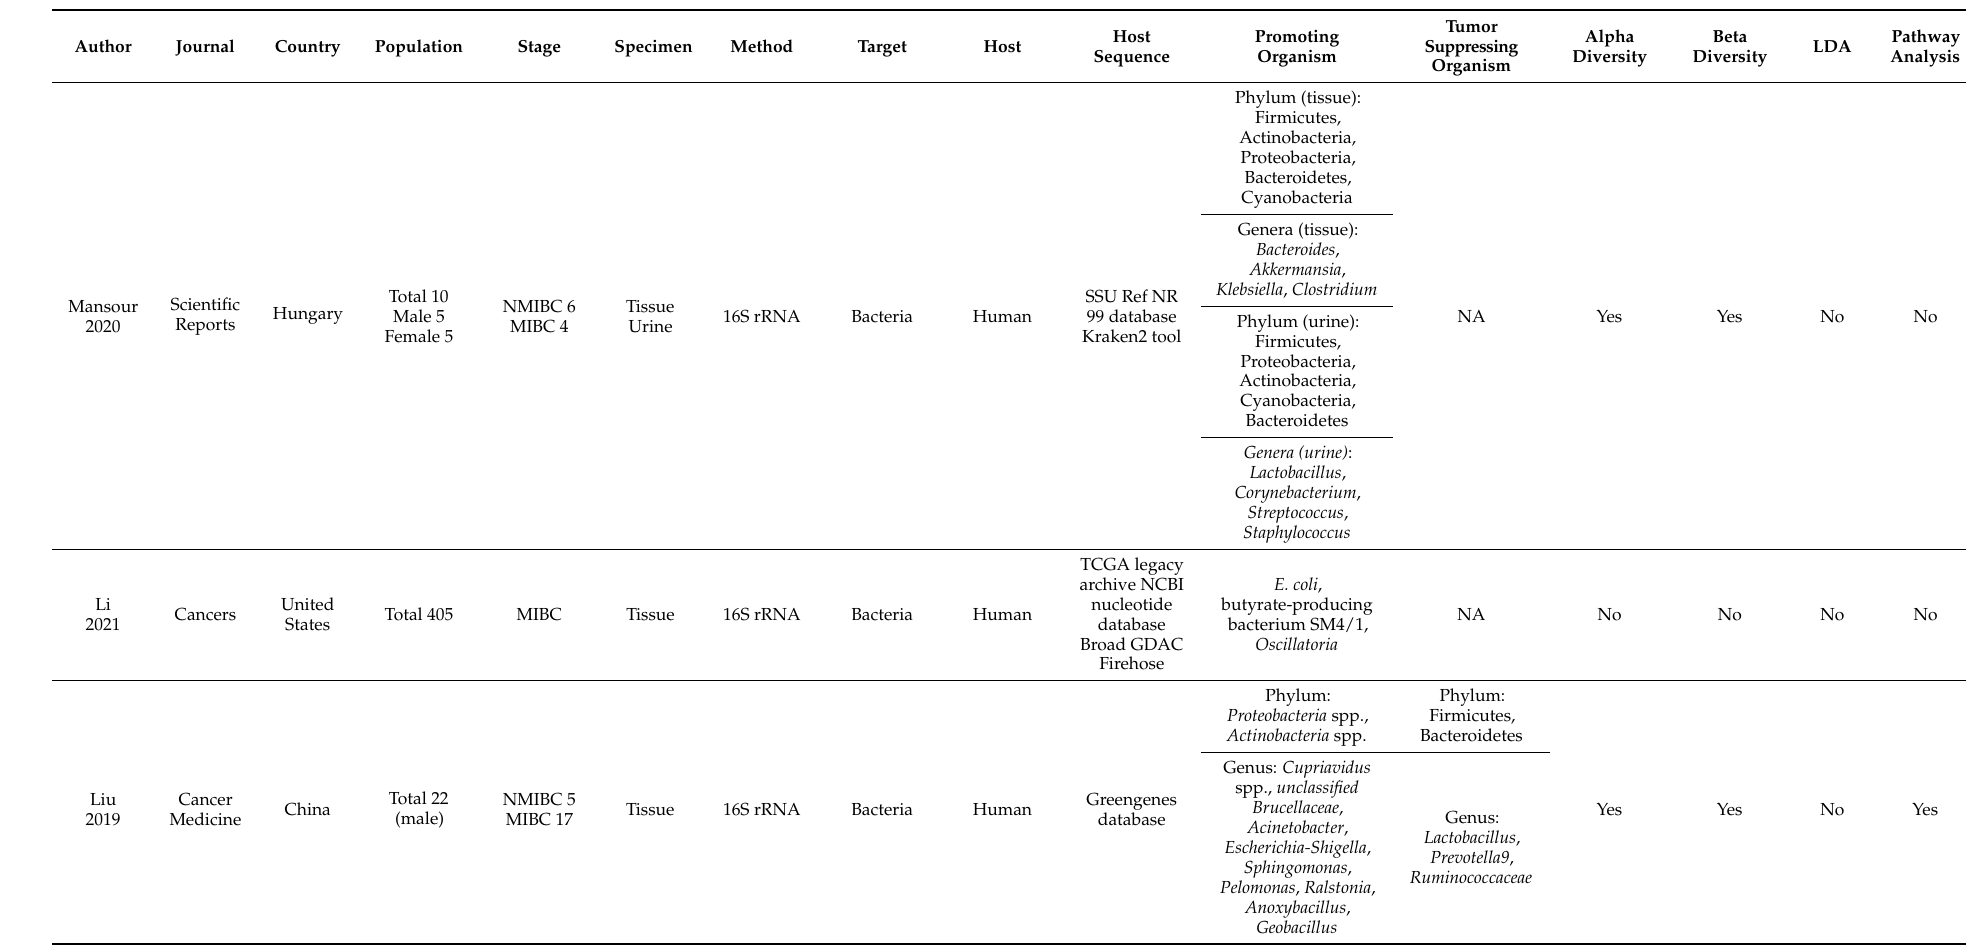
Table 1. Characteristics of studies included in the systematic